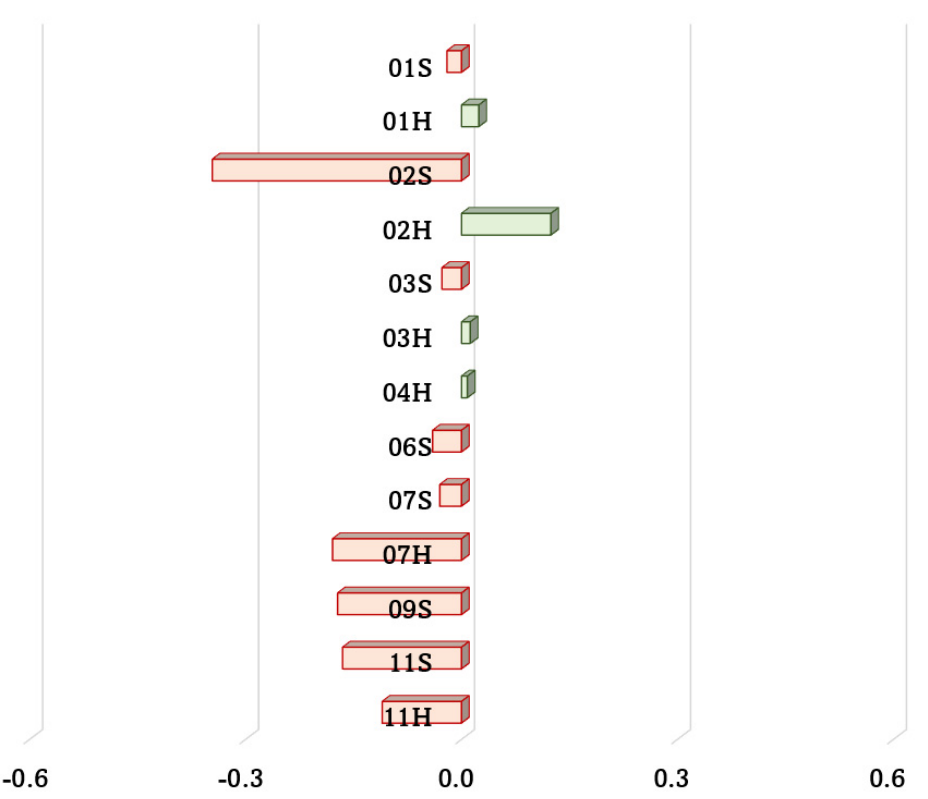
Figure 7. Strength of correlation between ADAS activations and facial expressions.